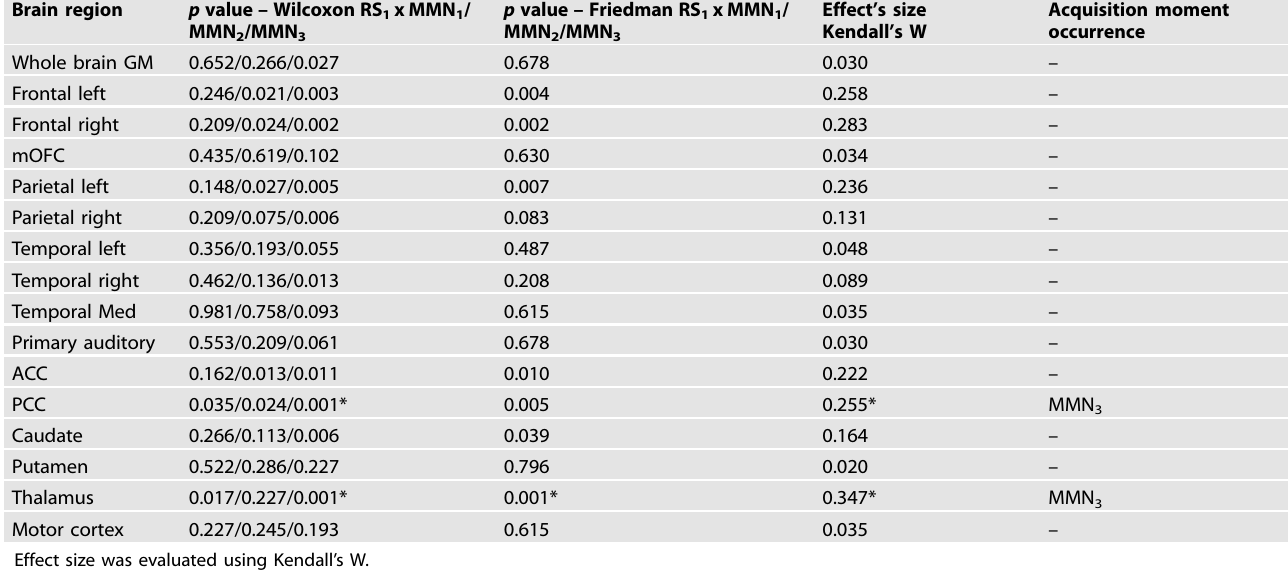
Table 2. Task effect results for anatomical brain regions analyzed with the Wilcoxon and Friedman tests and corrected using the Bonferroni method. Brain